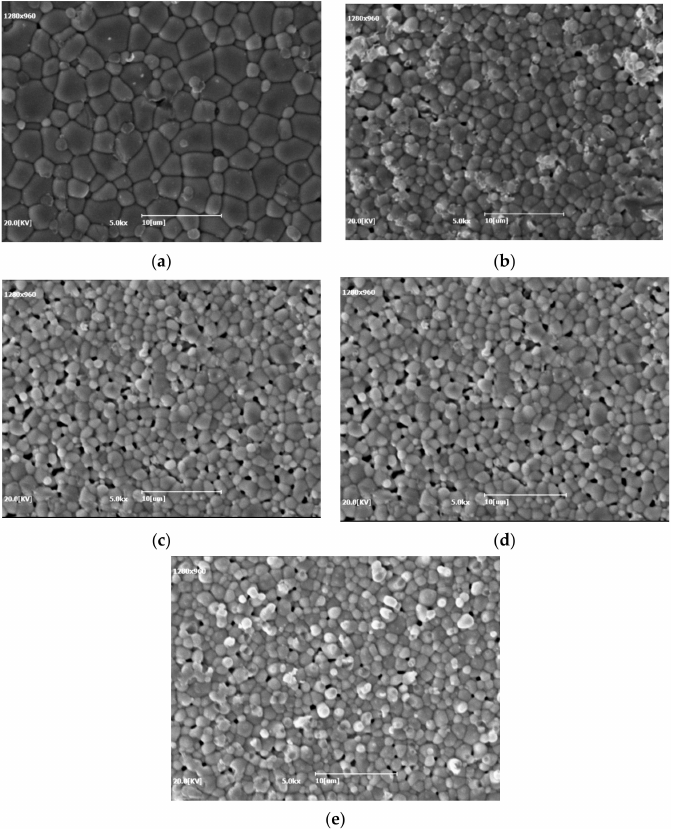
Figure 2. SEM micrographs with Sm substitution ( a ) x = 0. ( b ) x = 0.005 ( c ) x = 0.0075 ( d ) x = 0.01 ( e ) x =